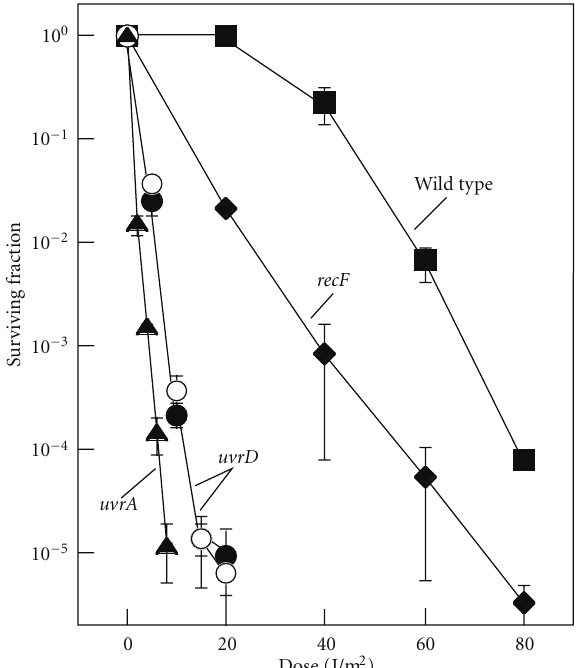
Figure 1: Cells lacking UvrD are hypersensitive to irradiation with UV light. Survival of wild-type ( (cid:2) ), recF ( (cid:3) ), uvrA ( (cid:4) ), uvrD::kan ( (cid:2) ), and uvrD::tet ( (cid:4) ) cultures following irradiation with the indicated UV doses. Error bars represent the standard error of the